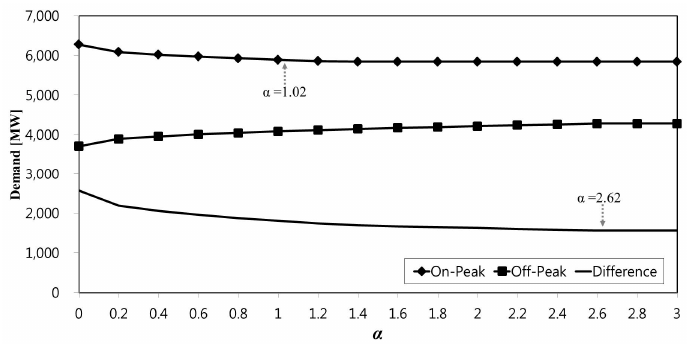
α for the weekly